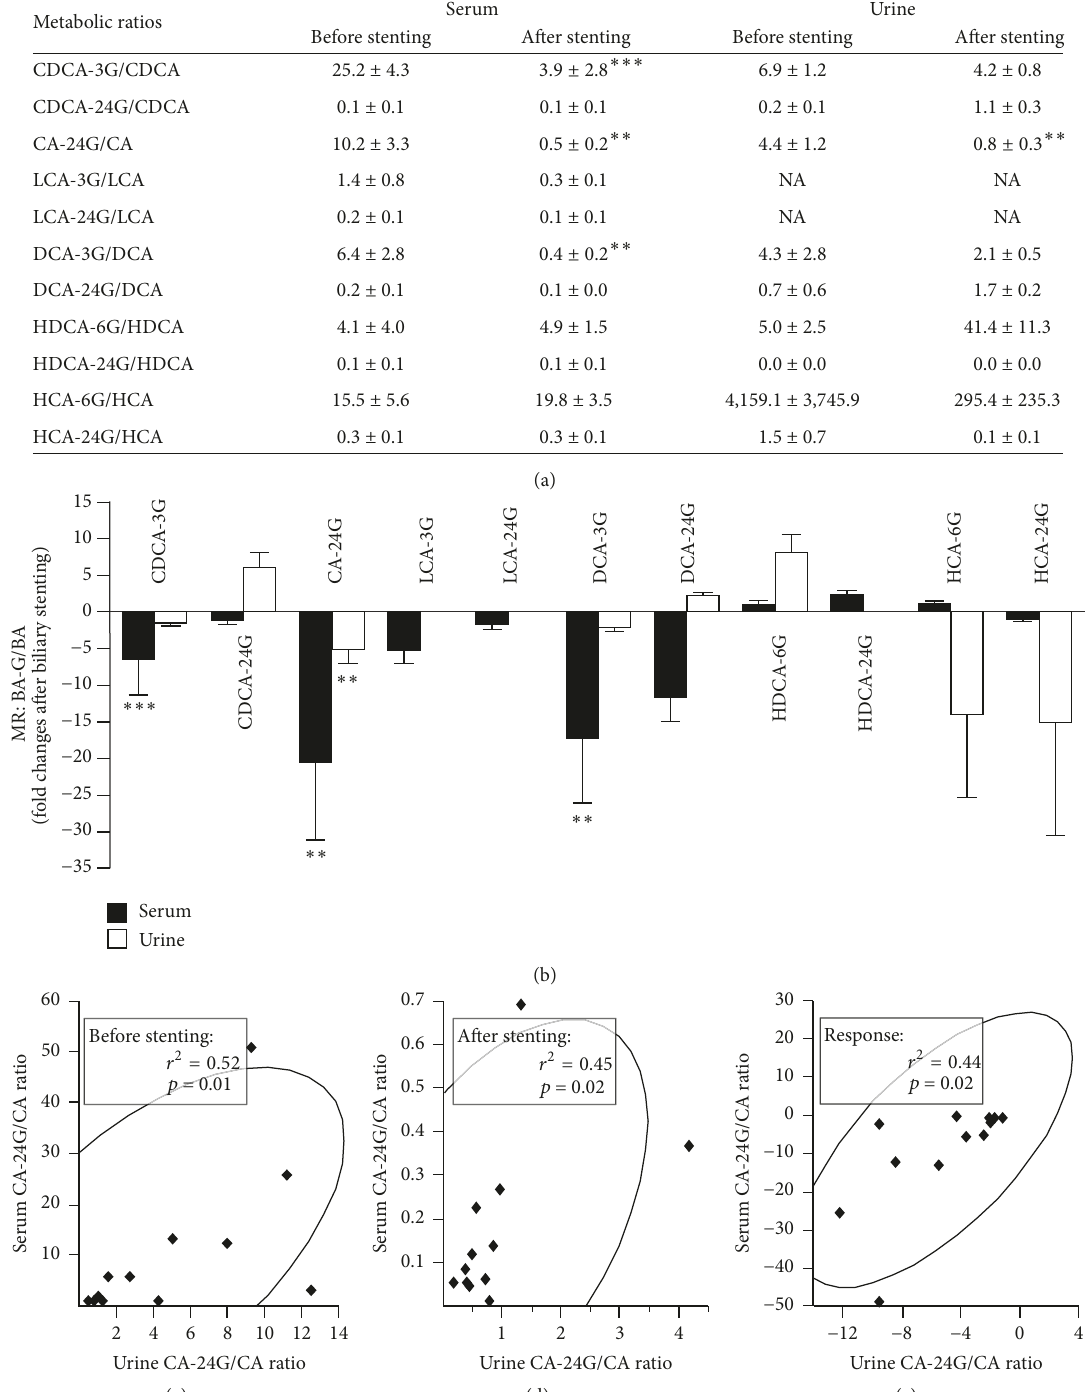
Figure 2: While bile flow restoration modulates metabolic ratios of bile acid glucuronides in a glucuronide- and fluid-dependent manner ((a) and (b)), the CA-24G/CA ratio is unique in being significantly associated with serum and urine (c–e). Serum and urine samples drawn before and after endoscopic biliary stenting from patients with stenosed bile ducts were analyzed for their concentrations in 11 bile acid-glucuronide speciesusingLC-MS/MS.Concentrationsofunconjugatedacidsweredeterminedasreported[20],andthemetabolicratioforeachspecies(a) was calculated as the ratio of glucuronide versus unconjugated precursor. (b) Black (serum; 𝑛 = 17 ) and white (urine; 𝑛 = 12 ) bars represent the mean ± SEM of fold changes (posttreatment values divided by pretreatment values) in MRs. Statistically significant differences between prestenting versus poststenting samples were determined using the Wilcoxon matched-pairs signed-rank test: ∗∗ 𝑝 < 0.01 ; ∗∗∗ 𝑝 < 0.001 . Other changes failed to reach statistical significance. The absence of unconjugated LCA in urine impaired such analysis for LCA-3 and -24G [20], while urine HDCA-24G/HDCA was null. (c–e) Correlation analyses of paired ( 𝑛 = 12 ) prestenting (c) and poststenting (d) serum and urine CA-24G/CA values or response to stenting determined as the difference between post- and pretreatment levels (e) were performed using the Spearman rank-order correlation ( 𝑟 2 ), and 𝑝 values for comparisons are